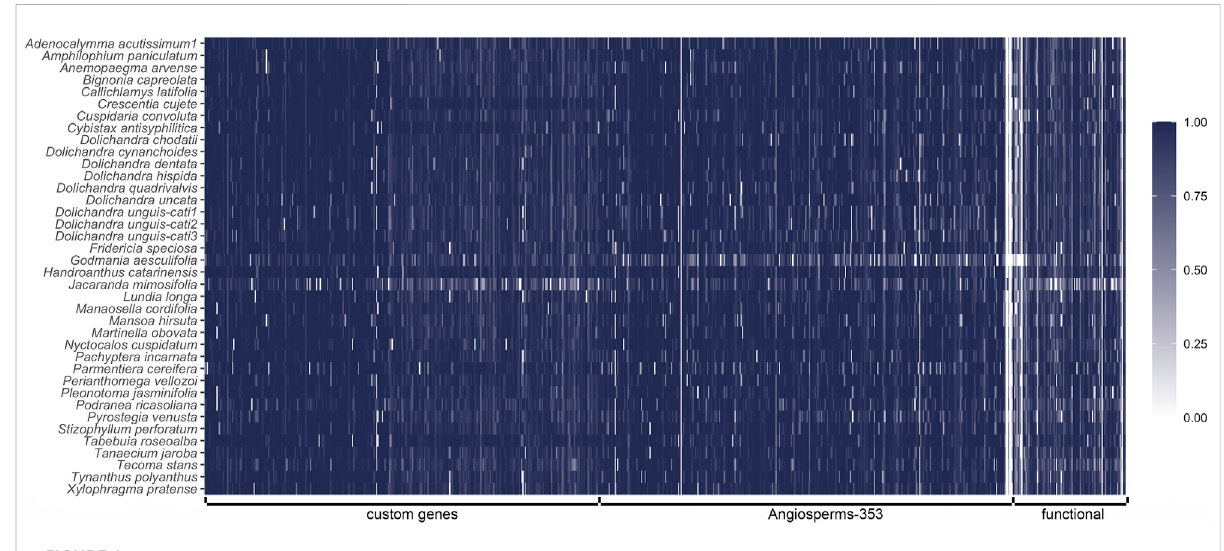
FIGURE 1 Recovered sequence heatmap for all the 771 genes targeted. Each row corresponds to a different specimen sampled, and each column correspond to a gene. Colors represent the length of the recovered sequence relative to the template sequence.